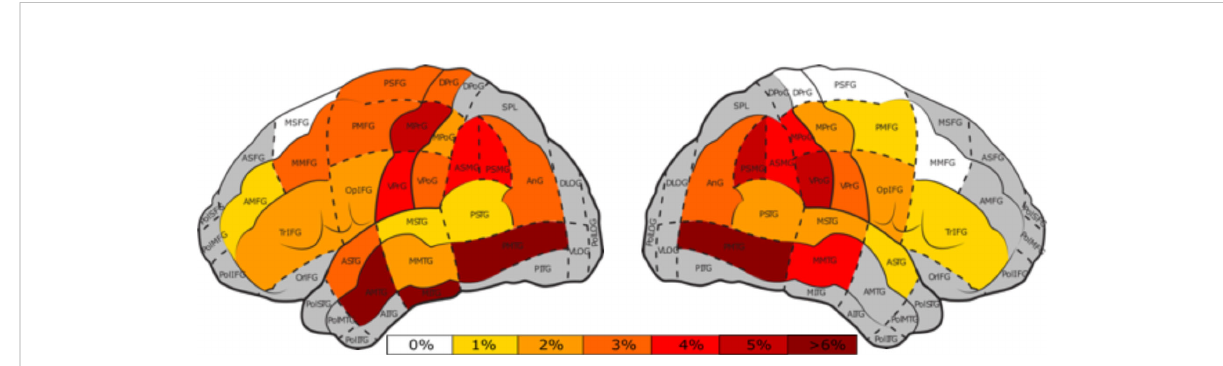
FIGURE 7 Percentage of nTMS errors in both hemispheres per cortical area (47) for the perisylvian protocol. Gray areas represent areas with less than 25 nTMS stimulations and white areas indicate areas that were stimulated without occurance of any errors. The color bar indicates the nTMS errors ranging from 0%, white, to >6%, dark